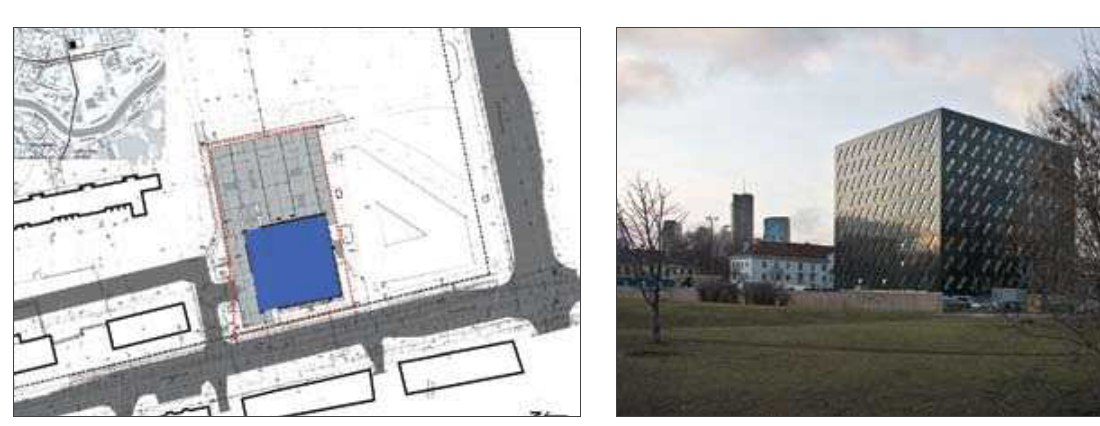
Fig. 10. Presecutor's Office building (south view), Vilnius.